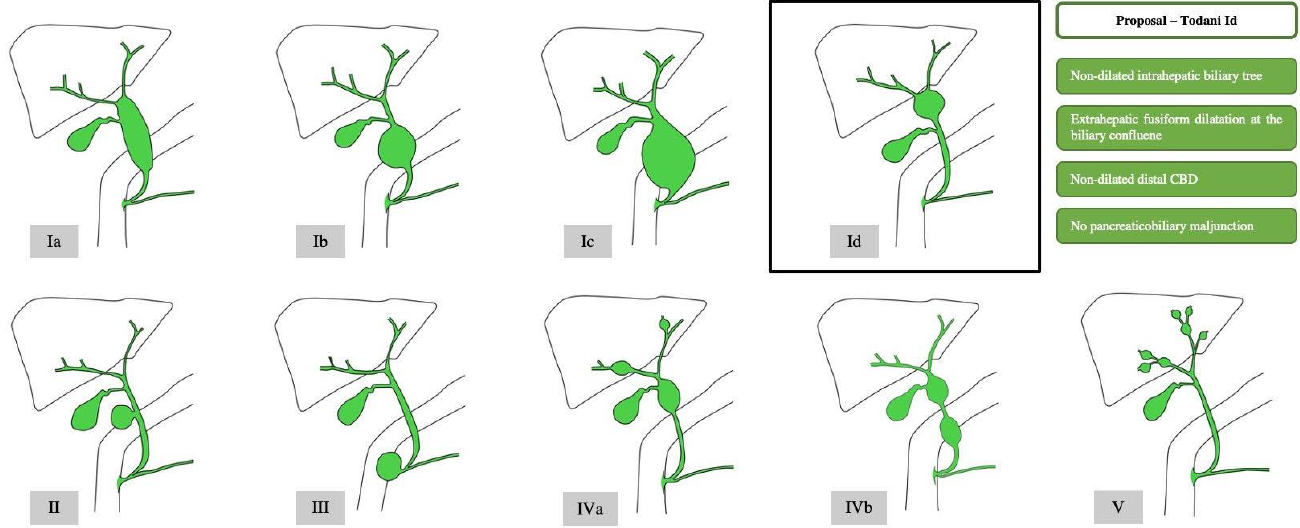
Figure 1. Todani classification of choledochal cysts, with proposed subtype ID.